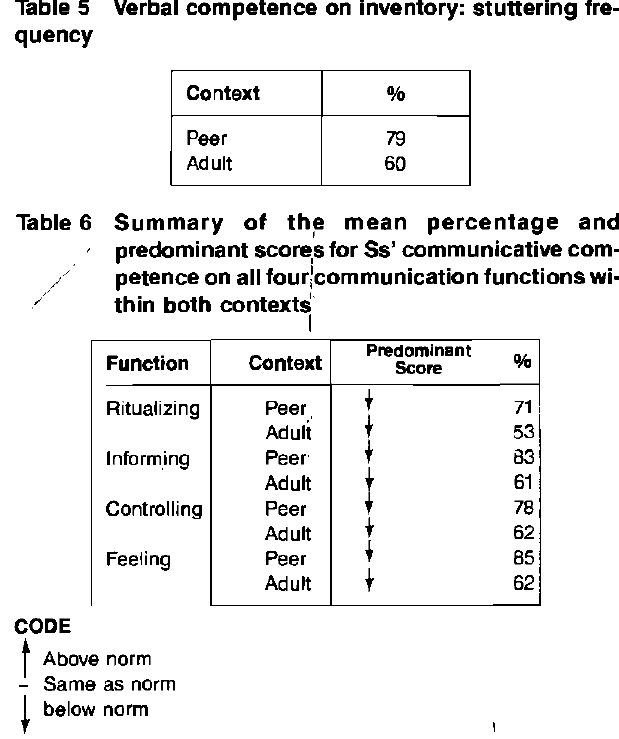
Table 5 Verbal competence on inventory: stuttering fre-